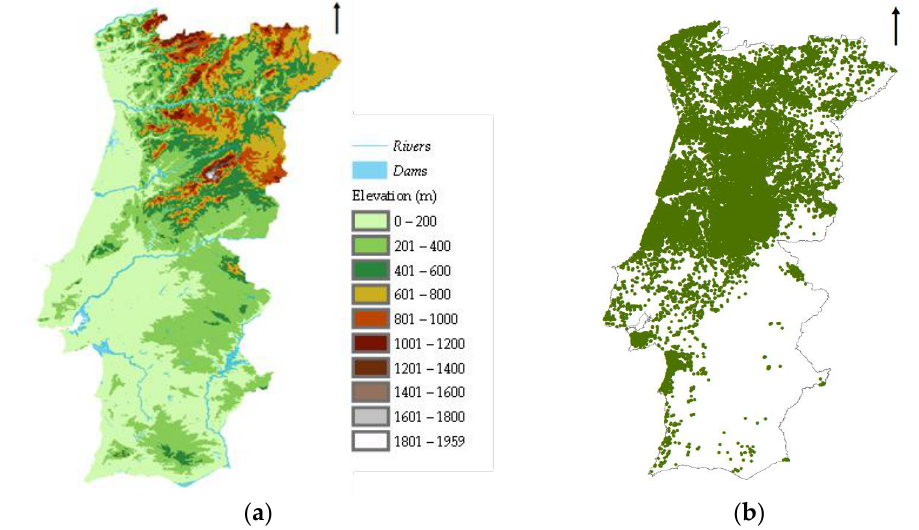
Figure 2. Study area: ( a ) Elevation; and ( b ) Maritime pine occurrences (green dots) extracted from COS1995.